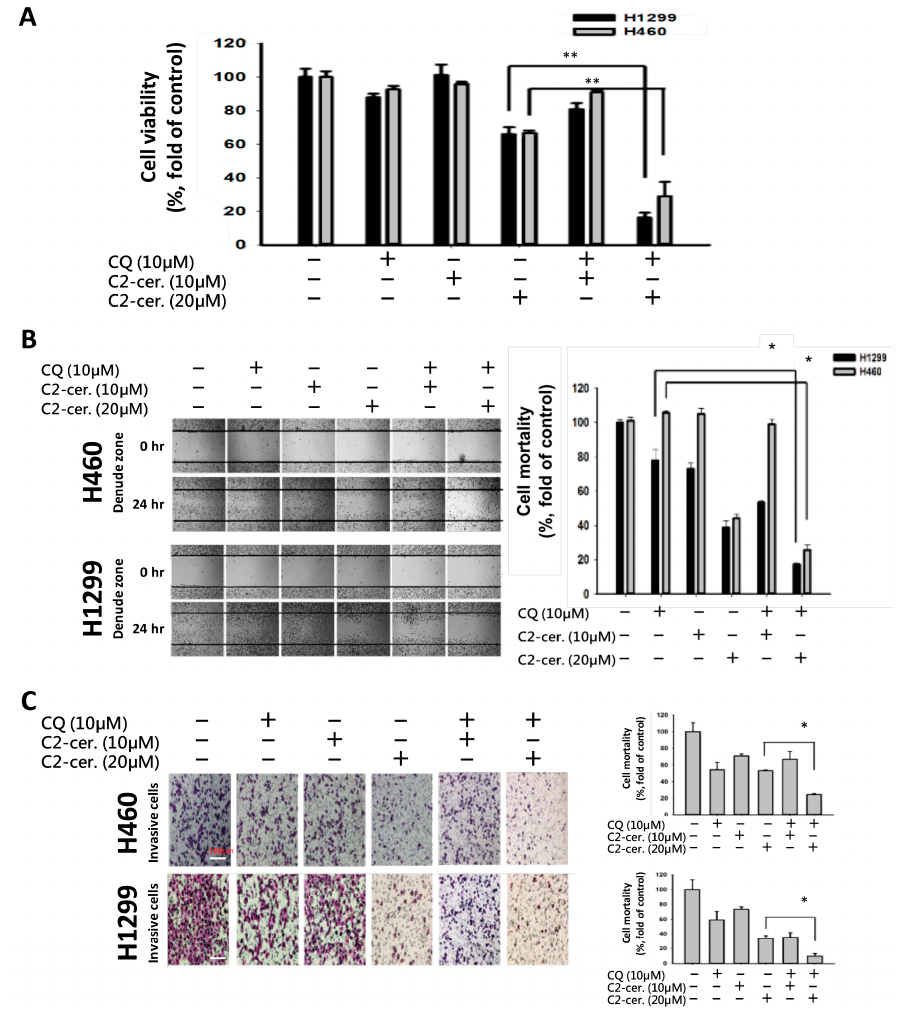
Figure 2. Combined treatment with C 2 -ceramide and chloroquine (CQ)-enhanced cytotoxicity and altered NSCLC cell behaviors. ( A ) Cell viability assay of H460 and H1299 cells after treatment with the indicated concentrations of C 2 -ceramide and CQ for 24 h. ** p < 0.01 ( B ) In vitro wound-healing assay of H460 and H1299 cells after treatment with the indicated concentrations of C 2 -ceramide and CQ for 24 h. Right panel: quantification of cell mortality. (4× Magnification; * p < 0.05) ( C ) In vitro invasion assay of H460 and H1299 cells after treatment with the indicated concentrations of C 2 -ceramide and CQ for 24 h. Right panel: quantification of the cell invasion index. * p < 0.05